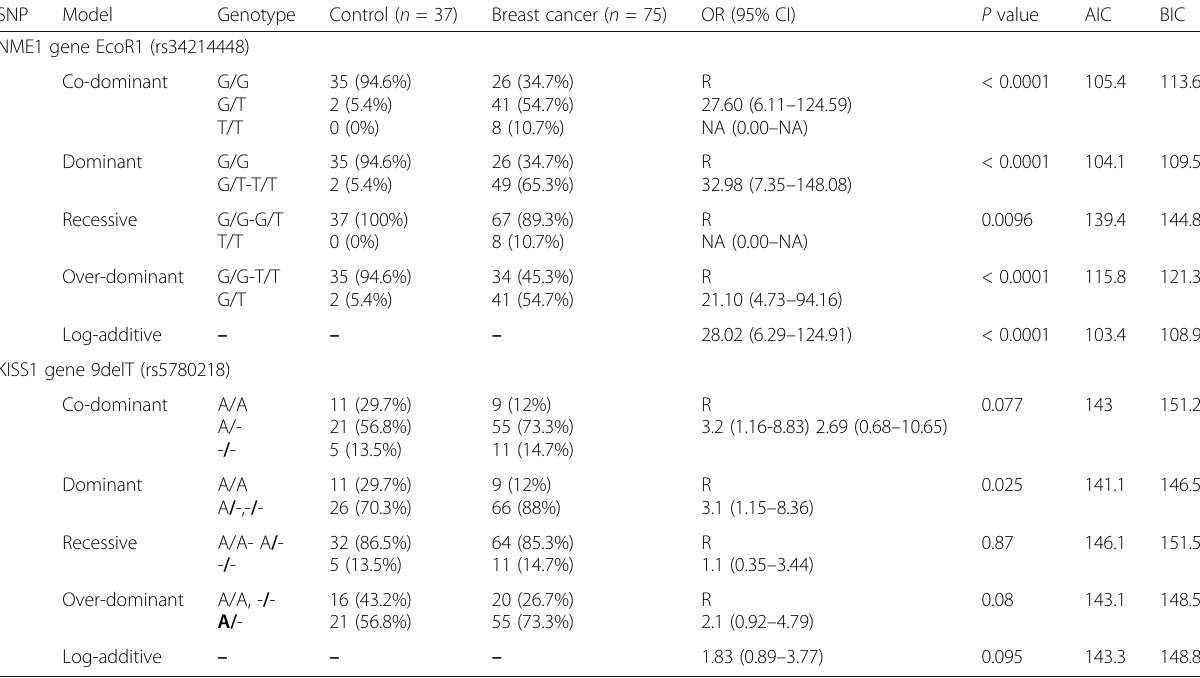
Table 3 Logistic regression analysis of the association between NME1 gene EcoR1 (rs34214448) and KISS1 gene 9 del T (rs5780218) SNPs and breast cancer